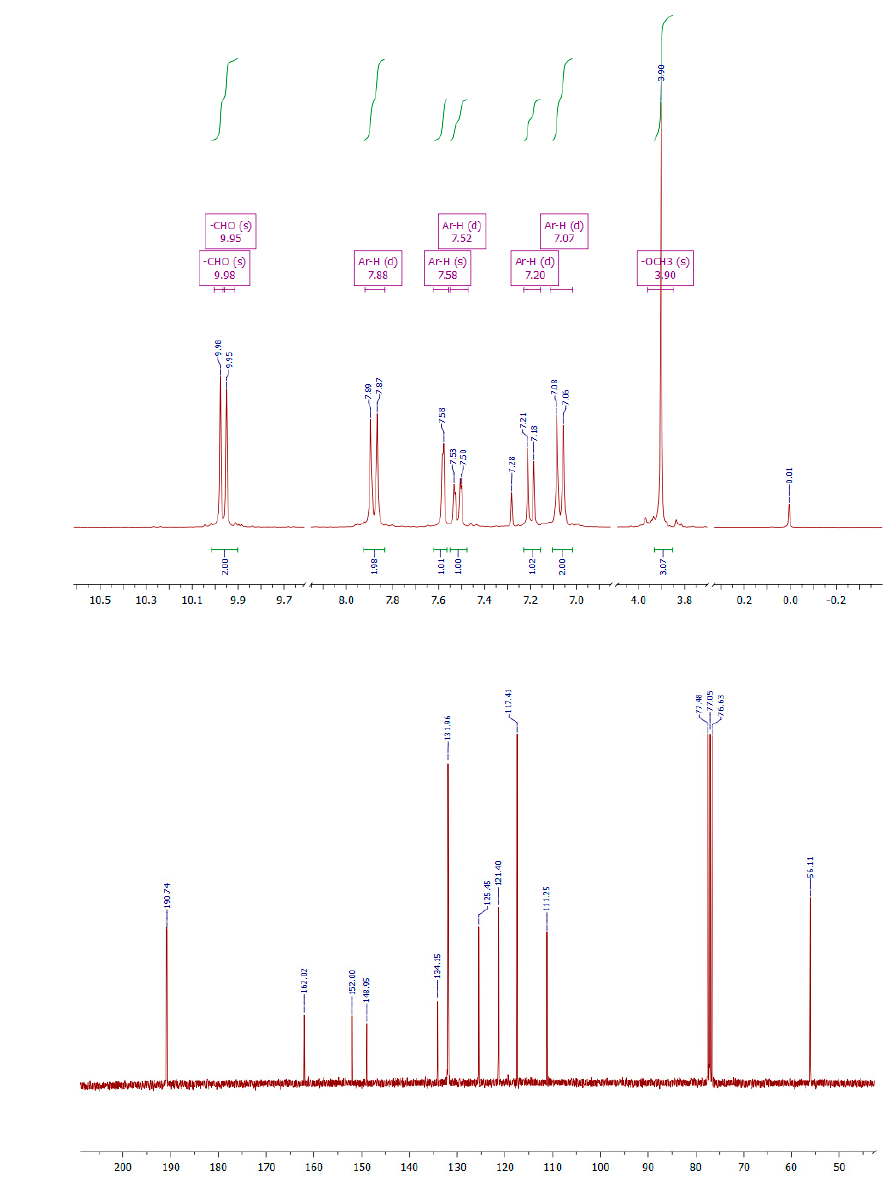
Figure 4. ( a ) 1 H NMR spectrum of 3b , and ( b ) 13 C NMR spectrum of 3b in CDCl 3.